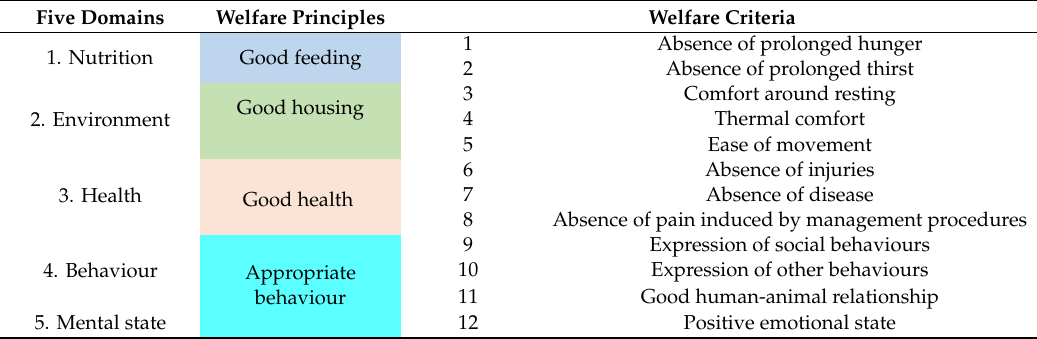
Table 1. The Five Domains of animal welfare [7] (left hand column) and their association with the Principles (middle column) and Criteria (right hand column) forming the basis of the Welfare Quality ® assessment [14] protocols. Colours are cross-referenced to Table 3.